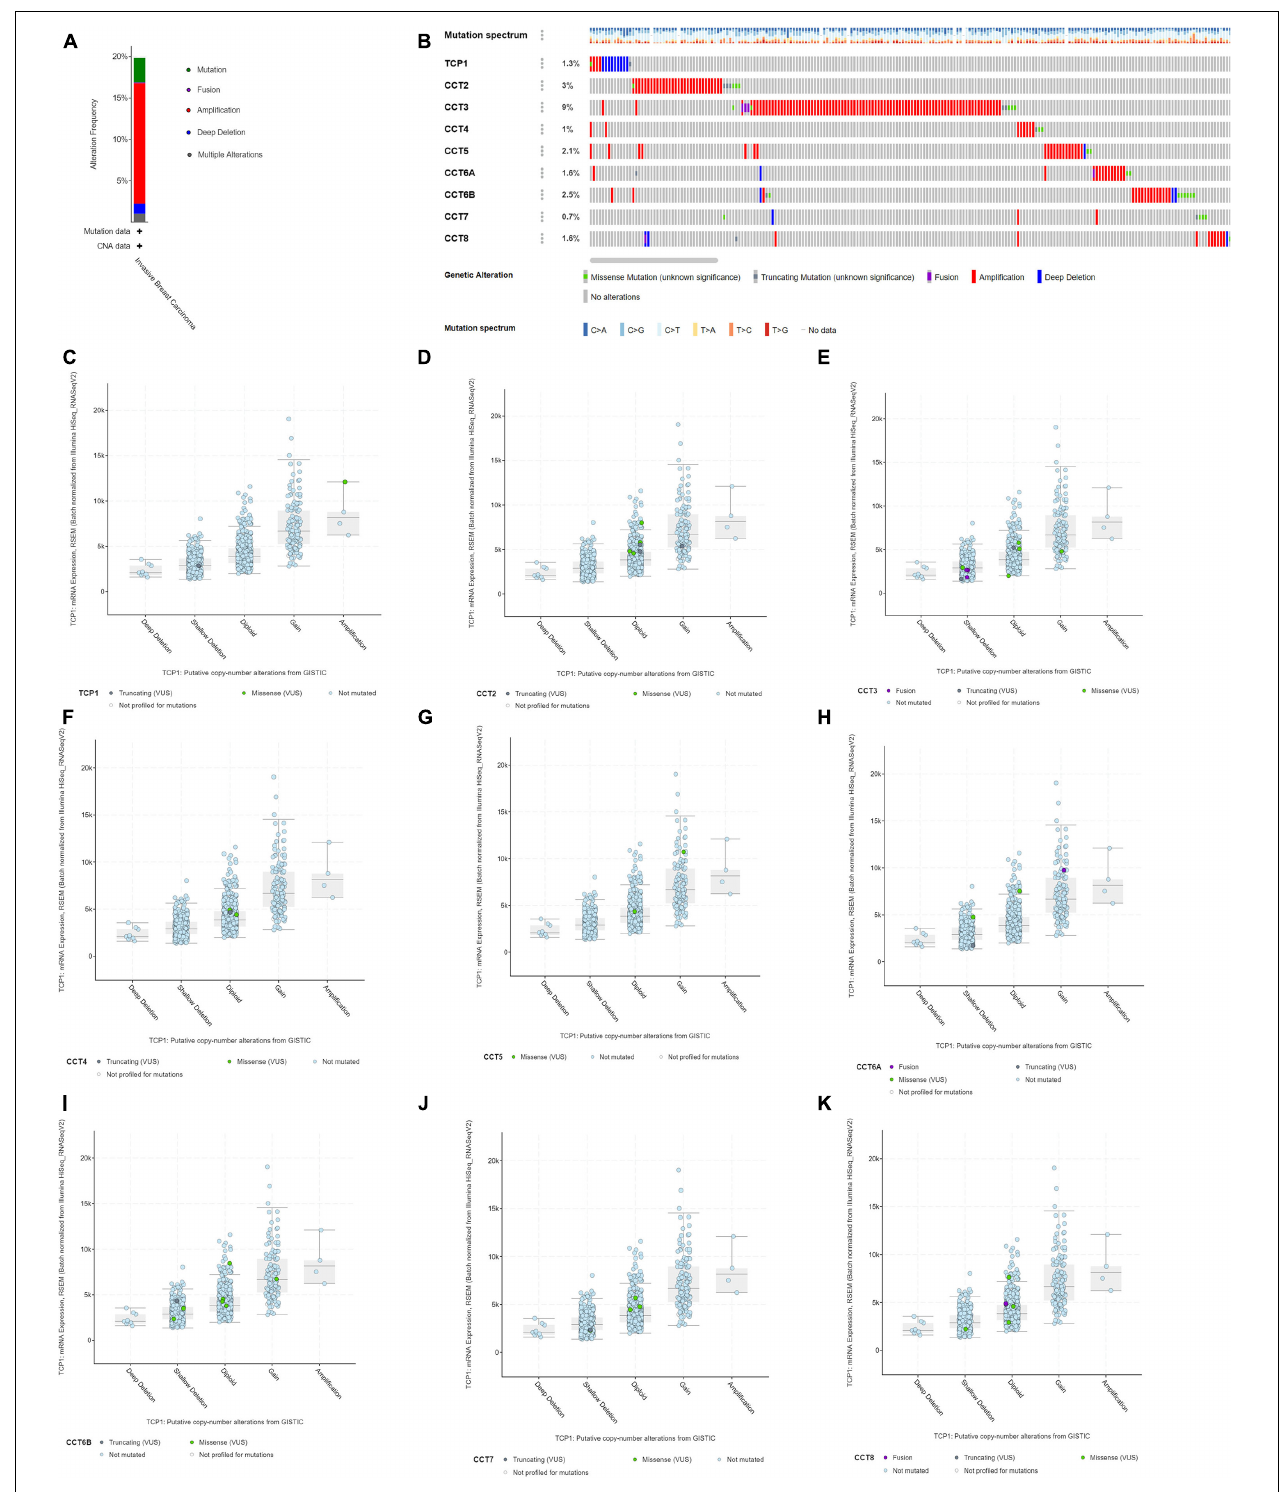
FIGURE 3 | Genetic mutation analysis of eight subunits of the chaperonin TRiC in BCa (cBioPortal). (A) Types of mutations and their proportions contained in BCa. (B) OncoPrint visual summary of genetic alteration on a query of eight subunits of the chaperonin TRiC in BCa. TCP1, CCT2, CCT3, CCT4, CCT5, CCT6A, CCT6B, CCT7, and CCT8 mutation rates were 1.3, 3, 9, 1, 2.1, 1.6, 2.5, 0.7, and 1.6%, respectively. (C–K) Copy gain (gain and amplification) of TRiC was linked with significant upregulated TRiC mRNA levels compared with the copy-loss (deep deletion and shallow deletion) and copy-neutral (diploid) patients (C) TCP1, (D) CCT2, (E) CCT3, (F) CCT4, (G) CCT5, (H) CCT6A, (I) CCT6B, (J) CCT7, and (K)